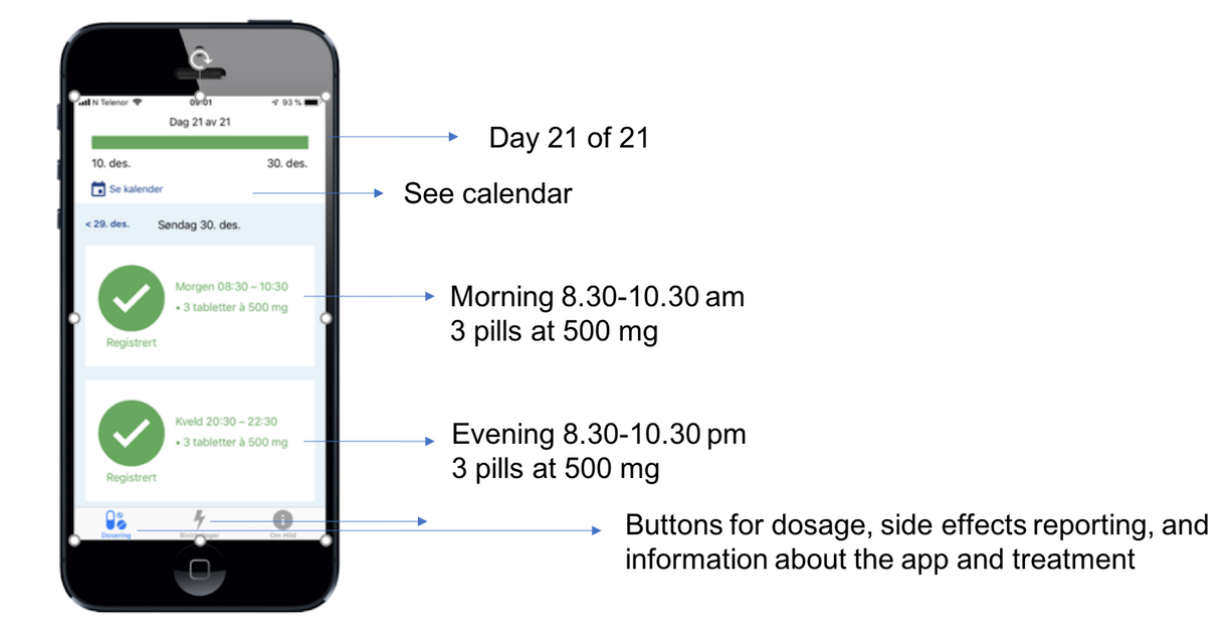
Figure 1. Features of the app for supporting medication adherence.